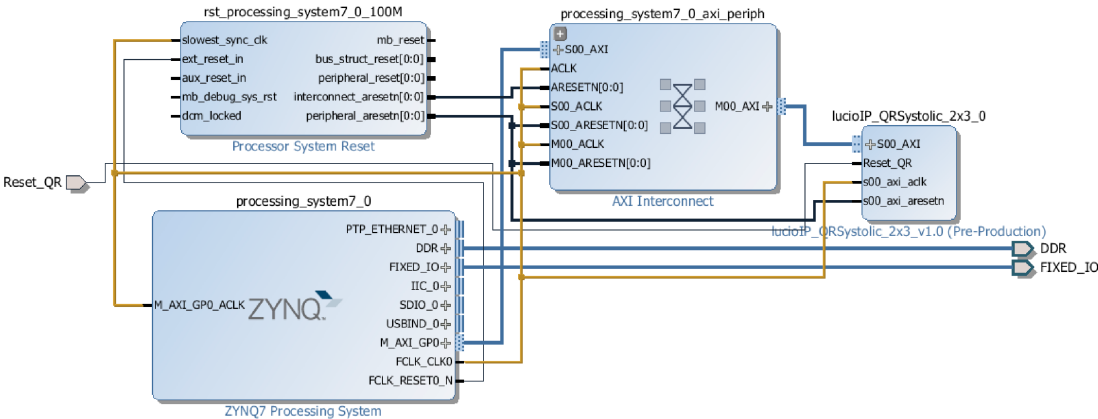
Figure 7. HW/SW codesign with the matrix inversion as the coprocessor